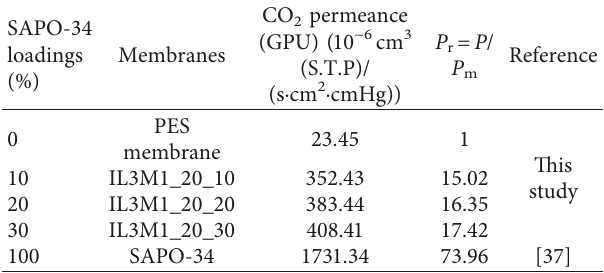
Table 2: Experimental results for CO branes and IL3Ms at 20 bar.